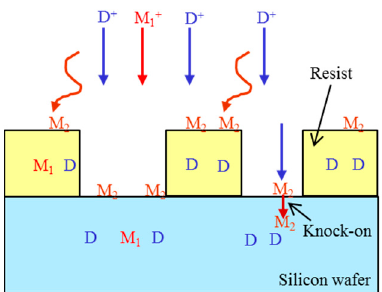
Figure 6. Cross-sectional illustration showing ion implantation process and metal contaminations. Straight line arrows denote energetic ion implantation, and wiggle line arrows denotes physisorption.